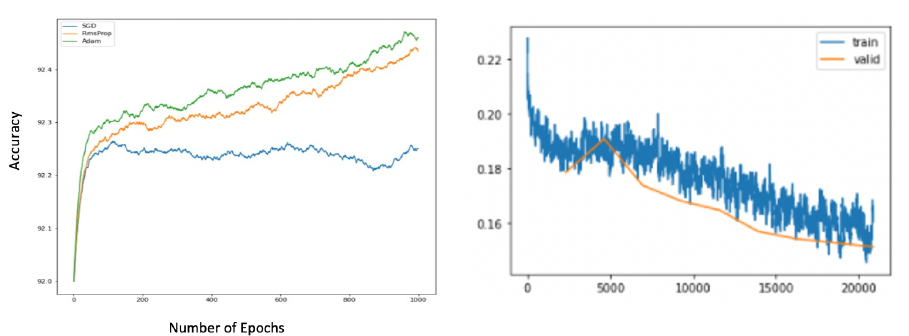
Figure 3. The accuracy of